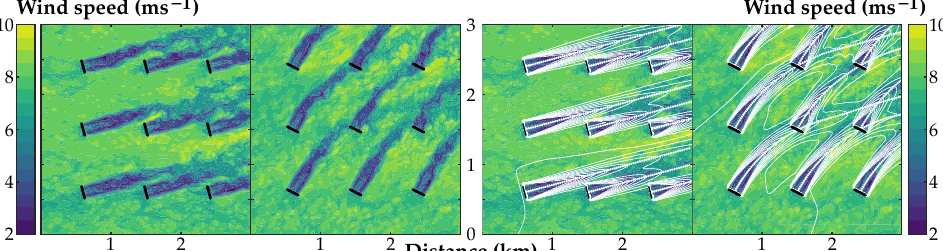
Figure 8. The left figure pair depicts the SOWFA flow field before and during the wind direction change at t 1 = 600 s and t 2 = 840 s, respectively. The right pair superimposes contour lines of the estimated FLORIDyn flow field as well as the